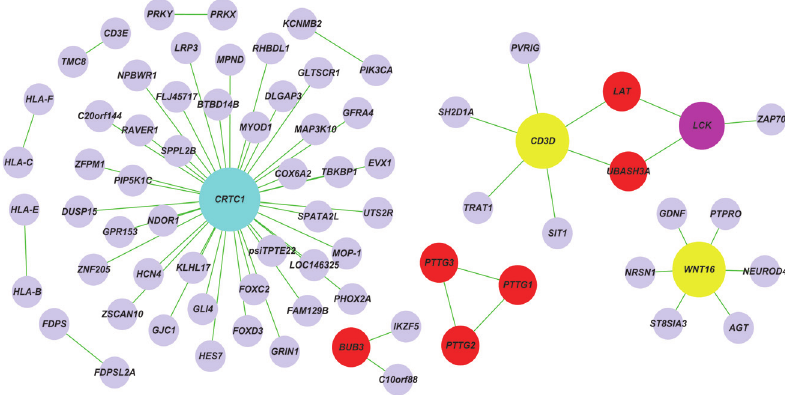
Figure 2. The co-expression network reconstructed by FastGCN using BRCA expression data with HTLV-I infection